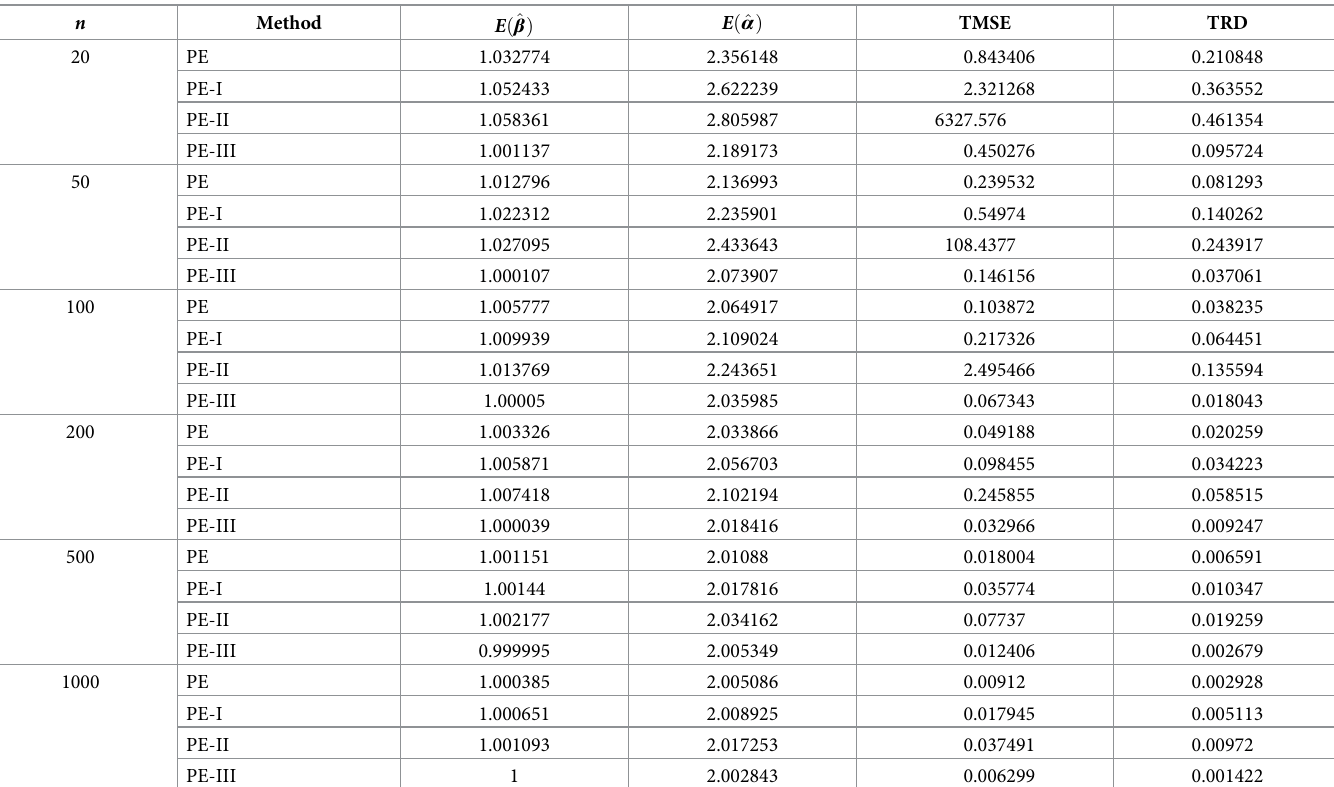
Table 3. Comparison of PE and modified PE for β = 1, α =